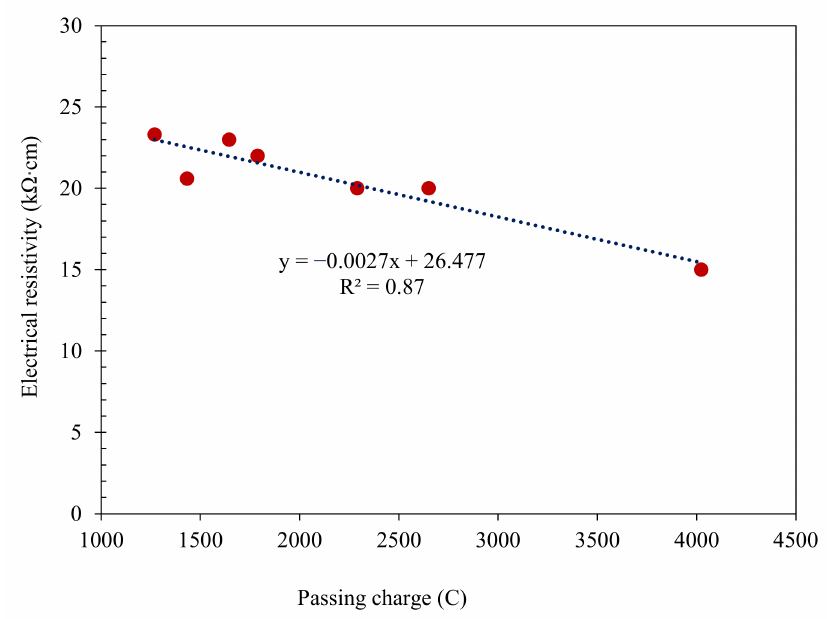
Figure 5. Statistical correlation between electrical resistivity and RCPT at 90 days curing for SC